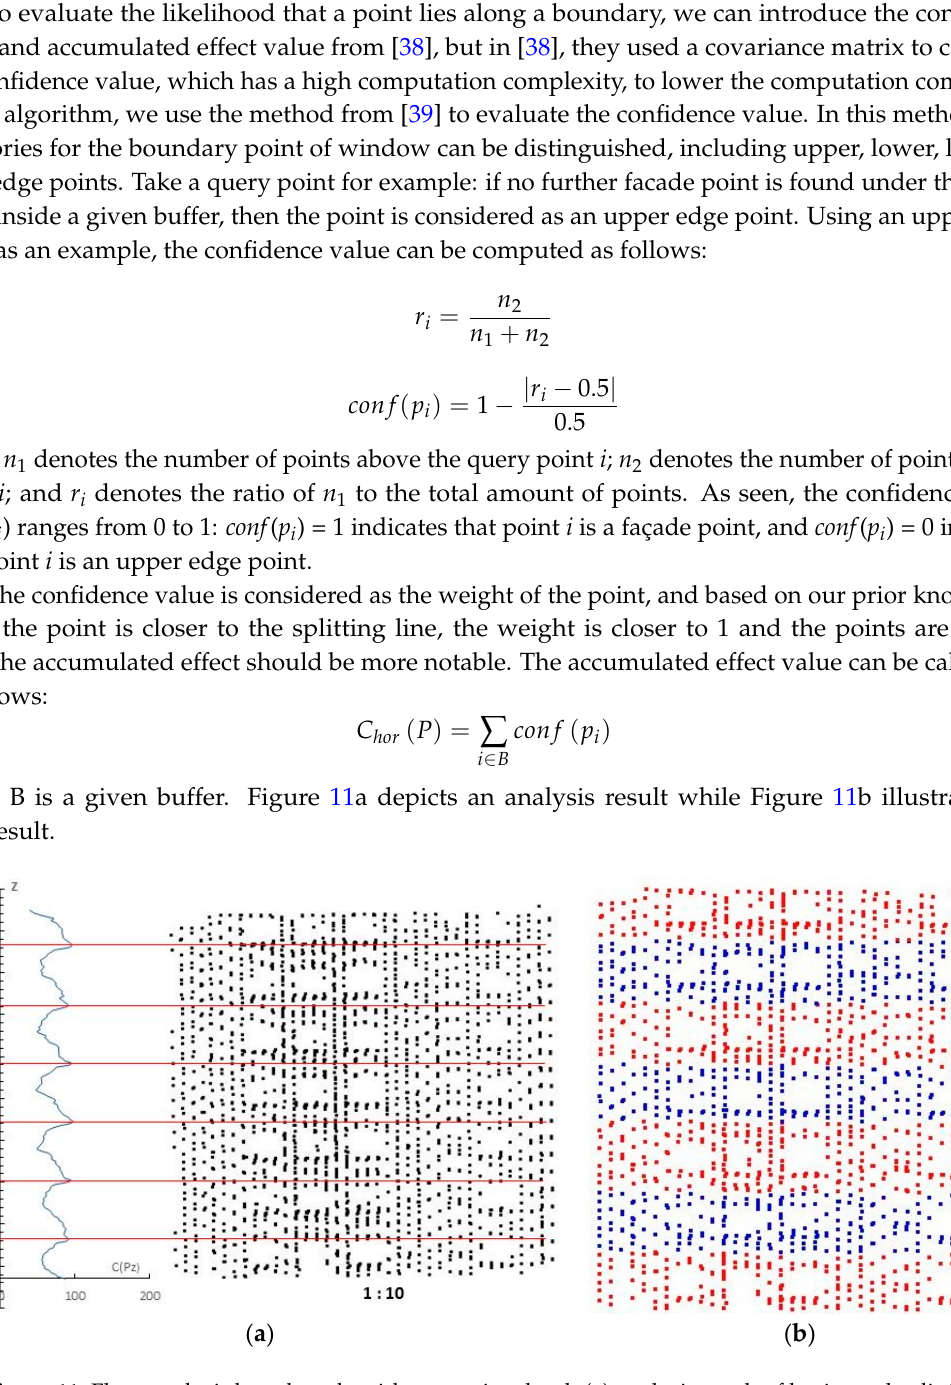
Figure 11. Floor analysis based on the airborne point cloud: ( a ) analysis result of horizontal splitting; and ( b ) final result after splitting.